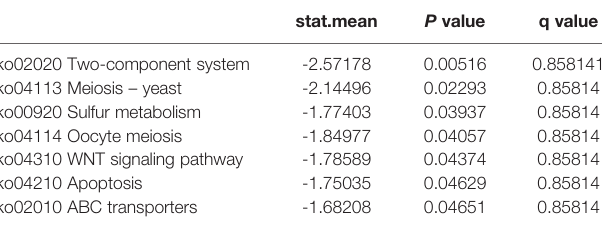
TABLE 3B | Downregulated KEGG pathways in psoriasis patients versus healthy subjects.